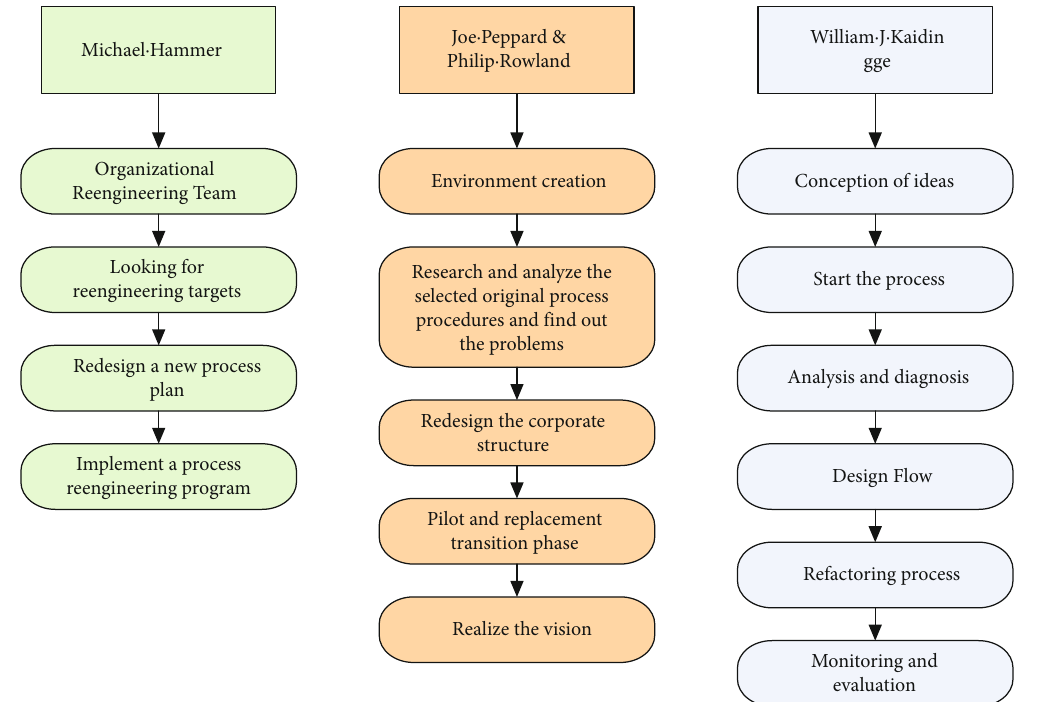
Figure 2: Three stages of the PR